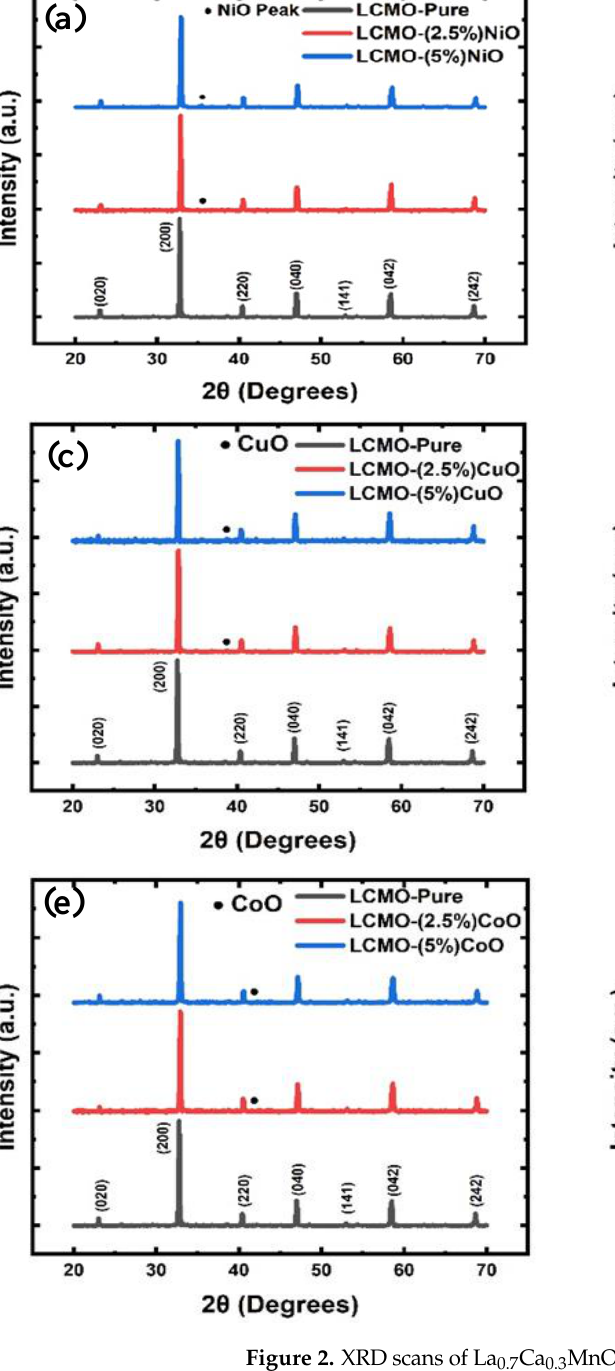
Figure 2. XRD scans of La 0.7 Ca 0.3 MnO 3 - x %MO composites ( a , c , e ) and long scans for MO peaks ( b , d , f ).